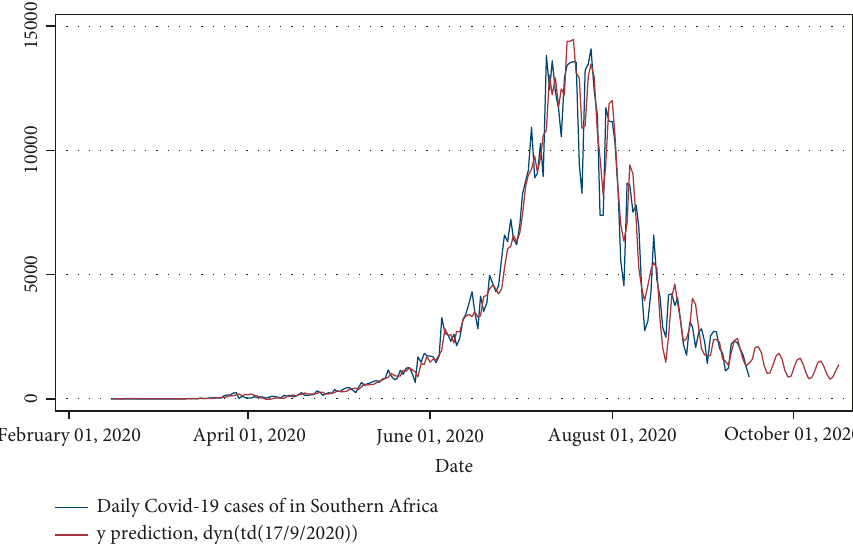
Figure 7: The plot of actual confirmed cases with the prediction results of the ARIMA model for Southern Africa.